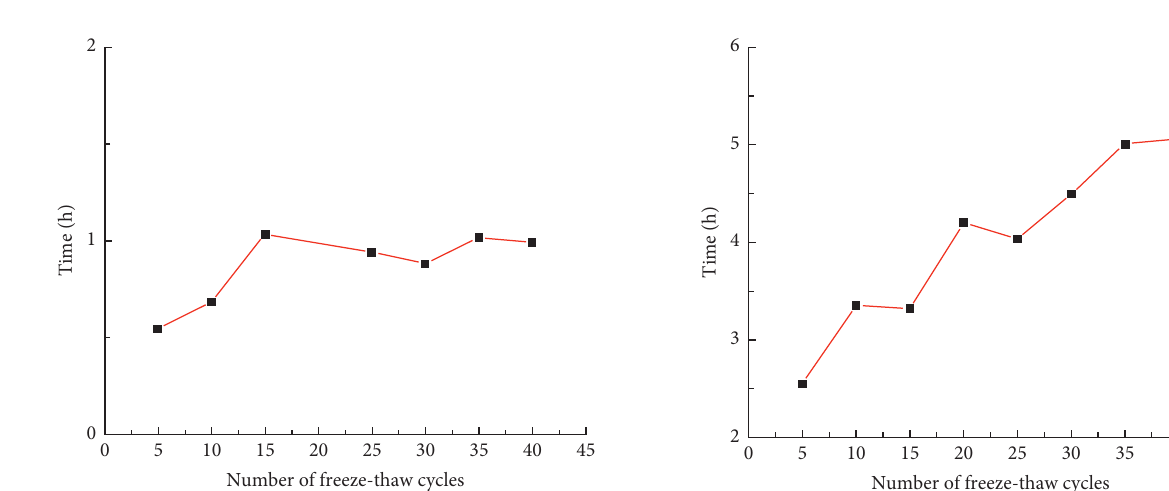
Figure 11: Time required for the deep freeze phase as a function of freeze-thaw cycles.